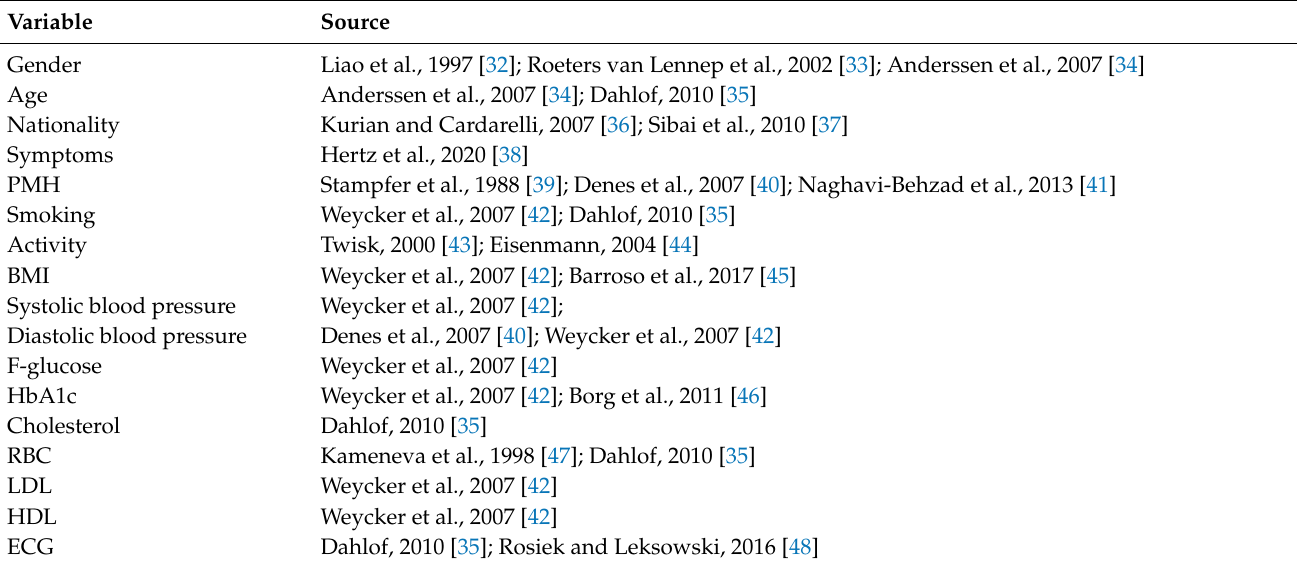
Table 2. Source of the CVD variables; see abbreviations in